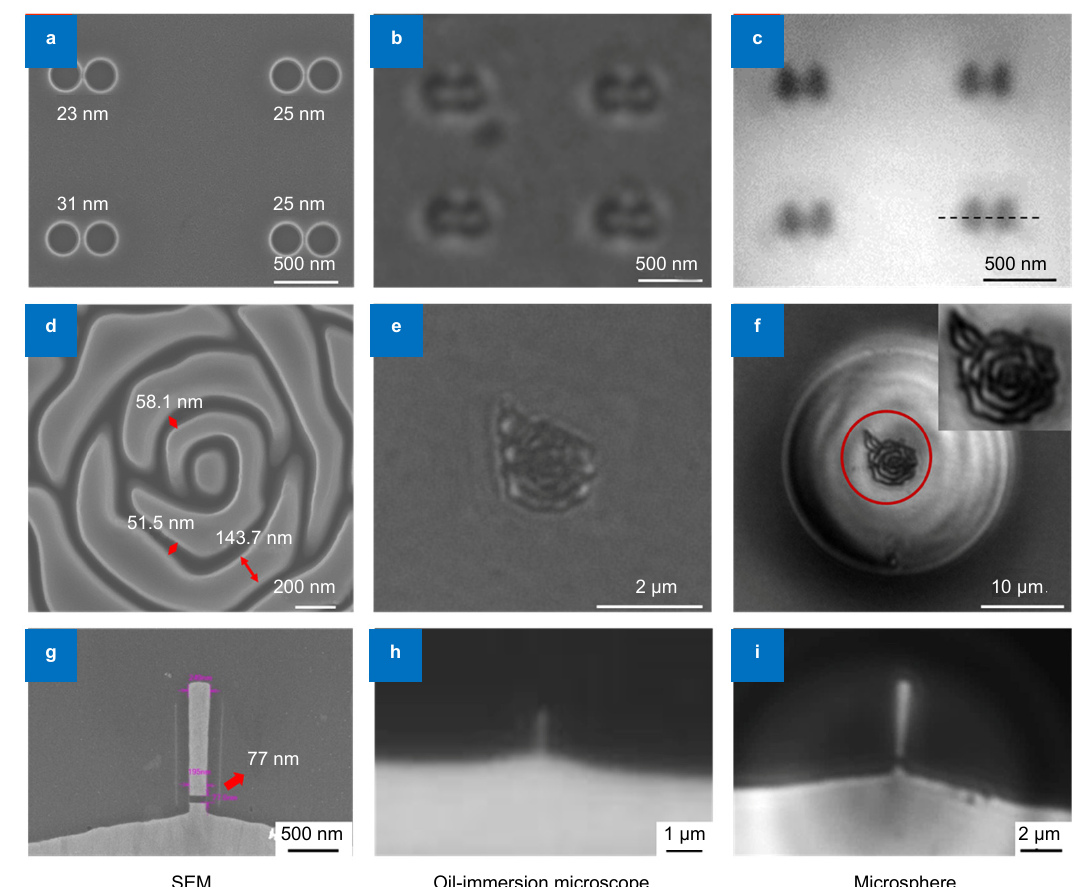
Fig. 3 | ( a ~ c ) Imaging of nano-dot pairs with nano-gap on a Si wafer. ( a ) SEM image of the samples, showing sizes of nano-gaps in between each pair of nano-dots. ( b ) Imaging of the samples by an oil-immersion microscope (neighboring nano-dots cannot be resolved clearly). ( c ) Neighboring separated nano-dots are resolved clearly by a microsphere with 20 μ m diameter. The back dash line in ( c ) indicates the line cut (the intensity analysis is presented in supplementary materials). ( d ~ f ) Imaging of samples with complex features (the “nano-rose”). ( d ) Zoomed-in SEM image with size notations, it shows that the typical line width of the structure is ~140 nm, and separated by nano-grooves with a typical size ranging from 50~60 nm. ( e ) Imaging result by the oil-immersion optical microscope. ( f ) Image under the 27 μ m microsphere in scanning mode. The diameter of the microsphere is larger in order to contain the entire nano-rose in the central region. (Compared to the microsphere used for the imaging of nano-dots, the microsphere with a larger diameter is chosen to ensure the entire nano-rose pattern is in the central region of the microsphere. Inset: zoomed-in image under the microsphere). ( g ~ i ) Imaging of a magnetic head in a hard disc drive from the production line. ( g ) SEM image of the magnetic head, with a nano-gap of 77 nm. ( h ) Imaging by a conventional oil-immersion microscope. ( i ) Imaging by the microsphere nanoscope in non-contact mode. The three columns represent images obtained by SEM, oil-immersion optical microscope (100×, NA 1.4), and microsphere nanoscope,